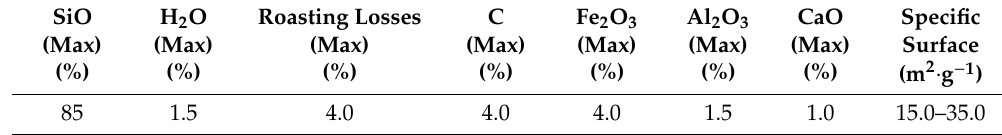
Table 8. Silica ash properties